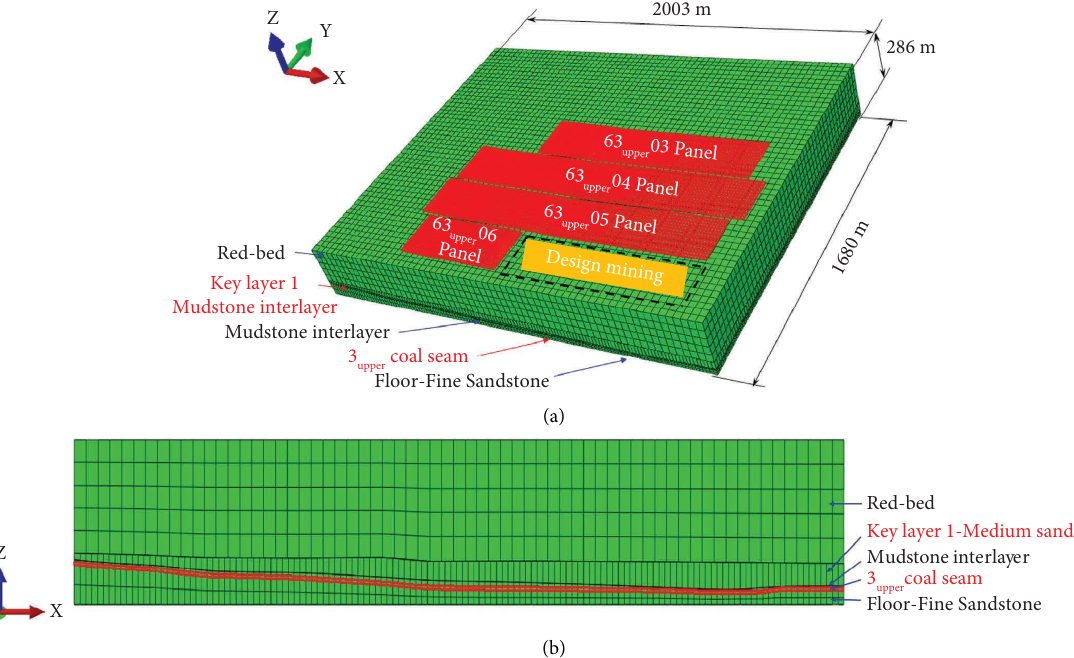
Figure 4: Numerical calculation model for overlying strata movement law in No.6 mining area. (a) 3D numerical simulation model. (b) Front view profle.